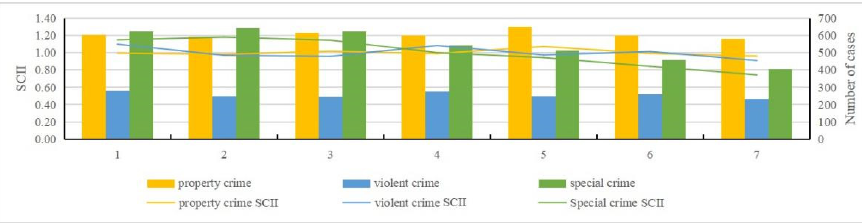
Figure 3. Standardized weekly crime intensity index and number of cases.